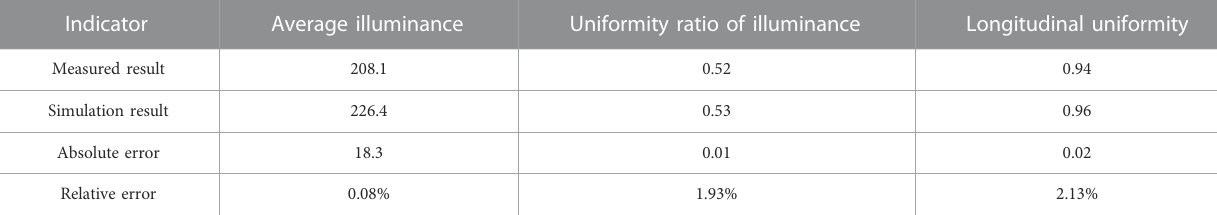
TABLE 1 Comparison between measured illuminance results and simulated illuminance results.